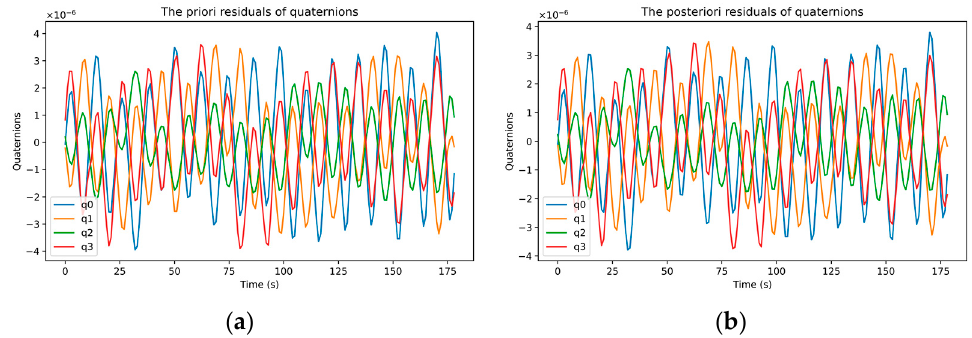
Figure 5. Residual errors sequence of attitude dynamics’ fitting of star camera quaternions: ( a ) the priori residuals of quaternions; ( b ) the posteriori residuals of quaternions.